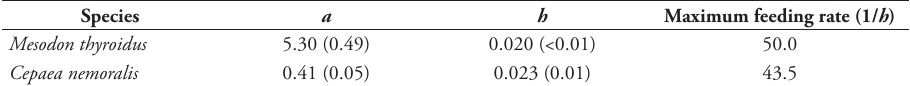
Table 1. Rogers’ Type II Functional Response parameters ( ± SE) for native ( M. thyroidus ) and non-native ( C. nemoralis ) snails, including attack rate ( a ), handling time ( h ), and maximum feeding rate (1/ h ). Species